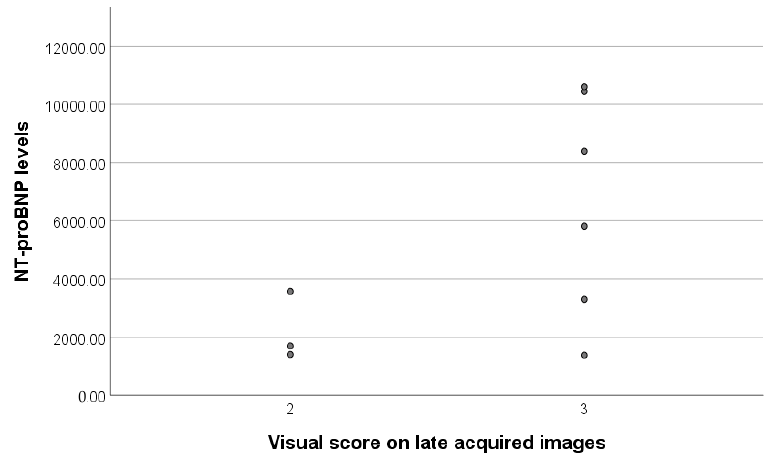
Figure 2. NT-proBNP levels in relation to the Visual Score results (Perugini score).